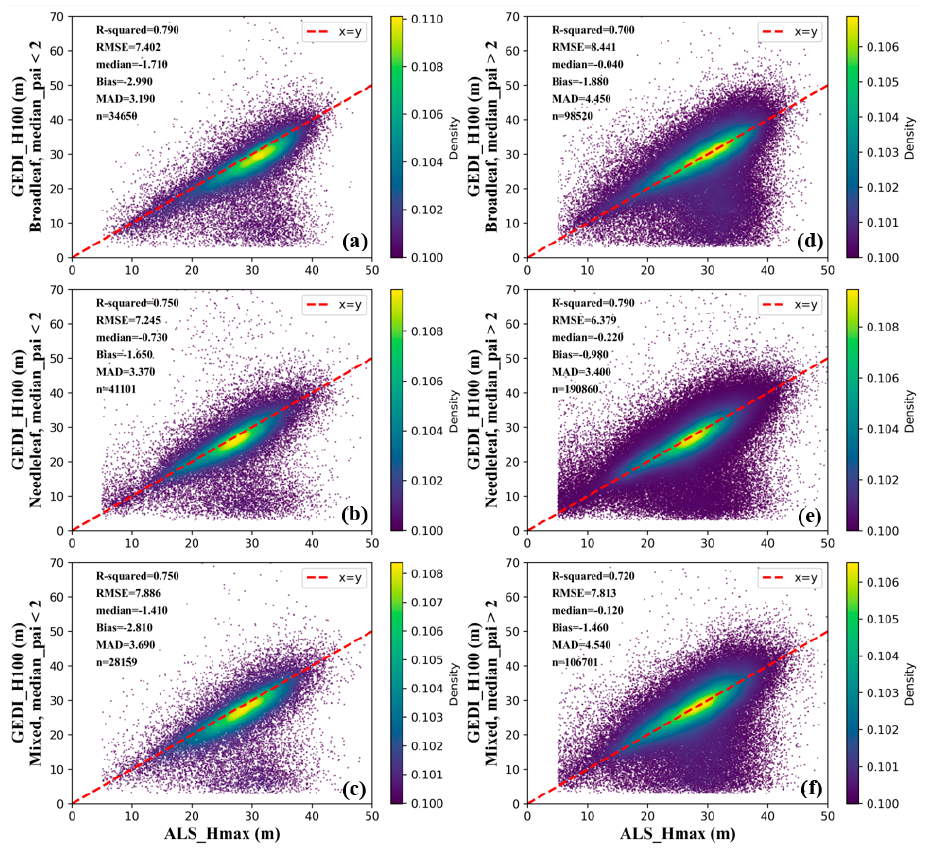
Figure 15. GEDI-H100 versus ALS-Hmax in the three forest types with median_pai < 2 ( a , b , c ) and median_pai > 2 ( d , e , f ).